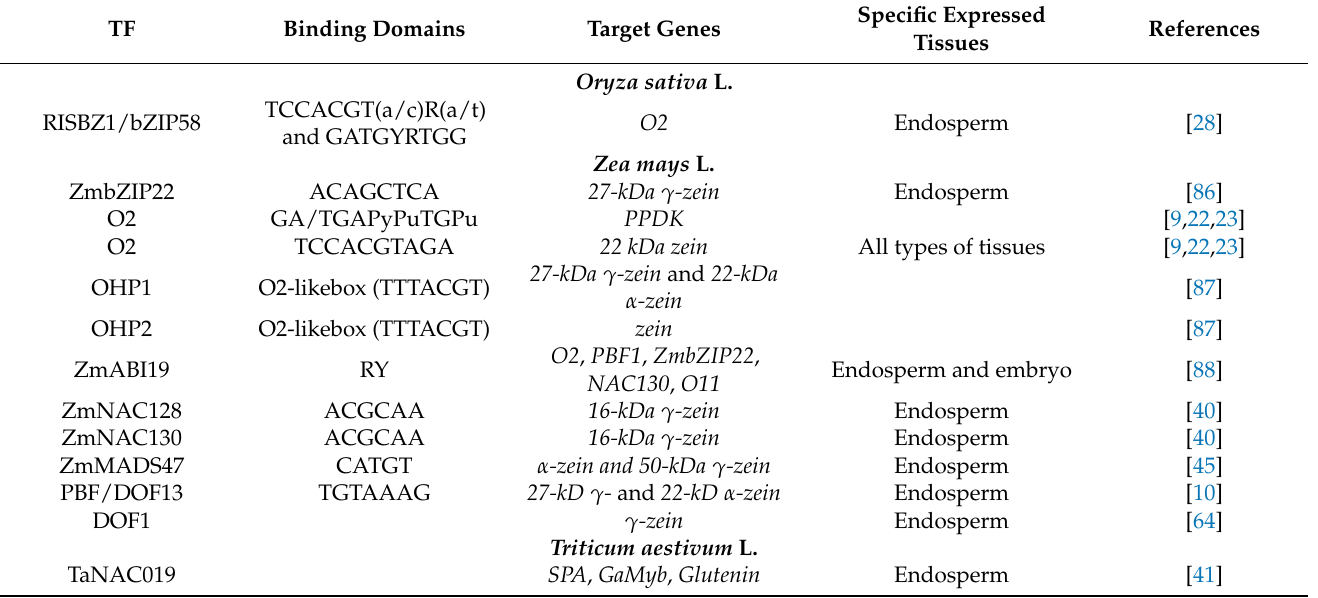
Table 2. Regulators indirectly affecting starch biosynthesis of cereal